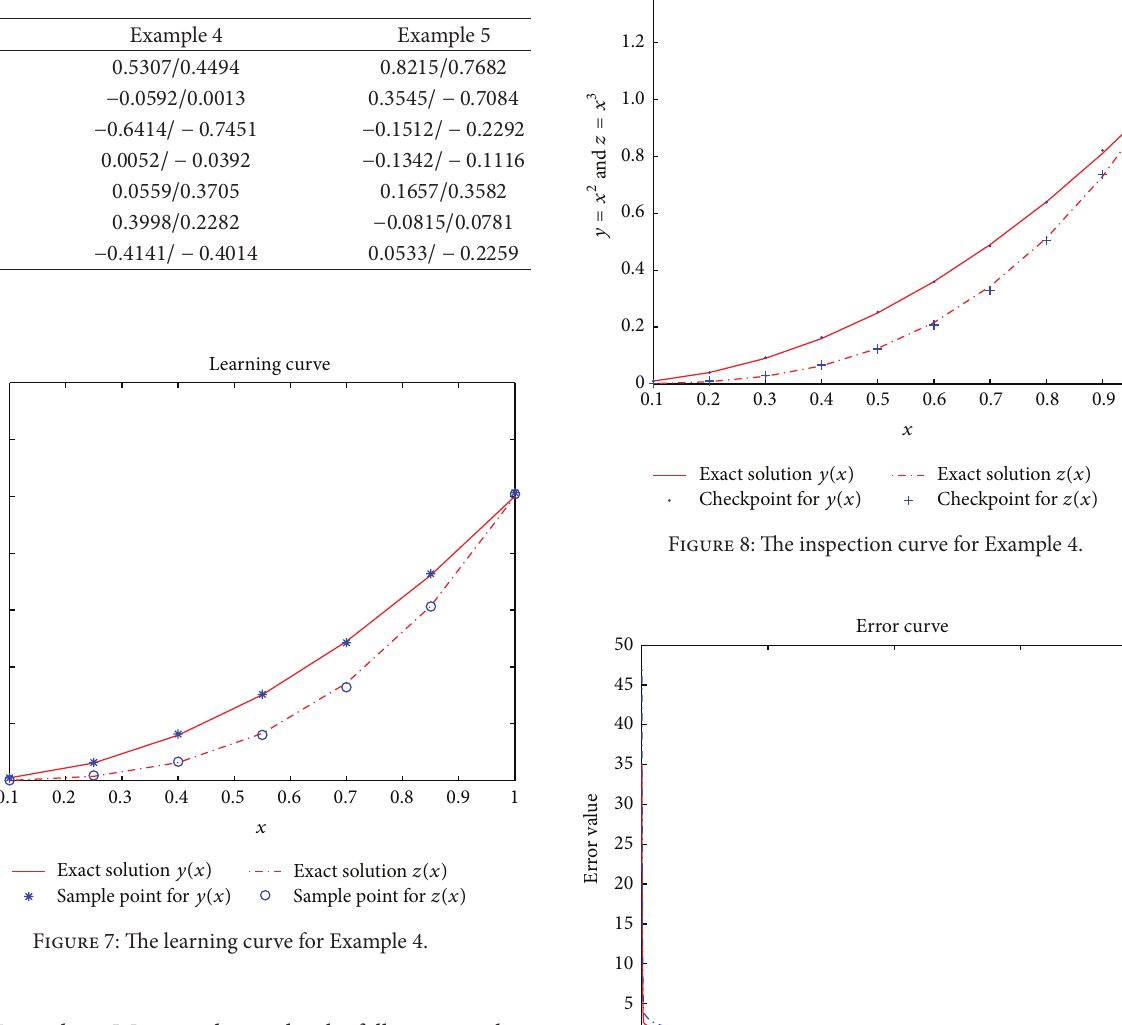
Table 5: Weights obtained along with the solution of Examples 4 and 5 .